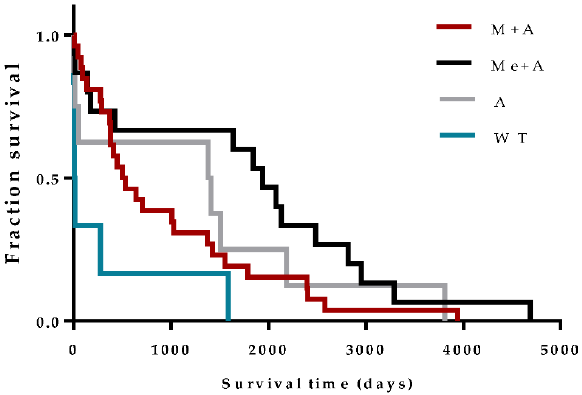
Figure 6. Influence of treatment on the survival time of patients with CanL. Log-rank (Mantel–Cox) test was used to compare the survival time of patients treated with miltefosine in association with allopurinol (M + A), meglumine antimoniate in association with allopurinol (Me + A), allopurinol (A) and untreated dogs (WT). Only events (death) were